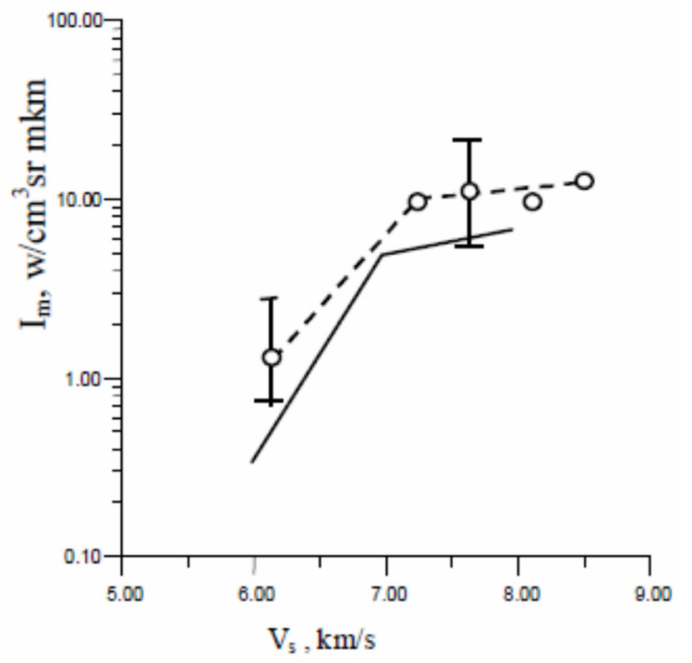
Figure 42. Peak values of radiation intensity (I m ) of CO(4+) behind the shock-wave as function of velocity: Curve–calculation, –measured radiation intensity (from (cid:35)